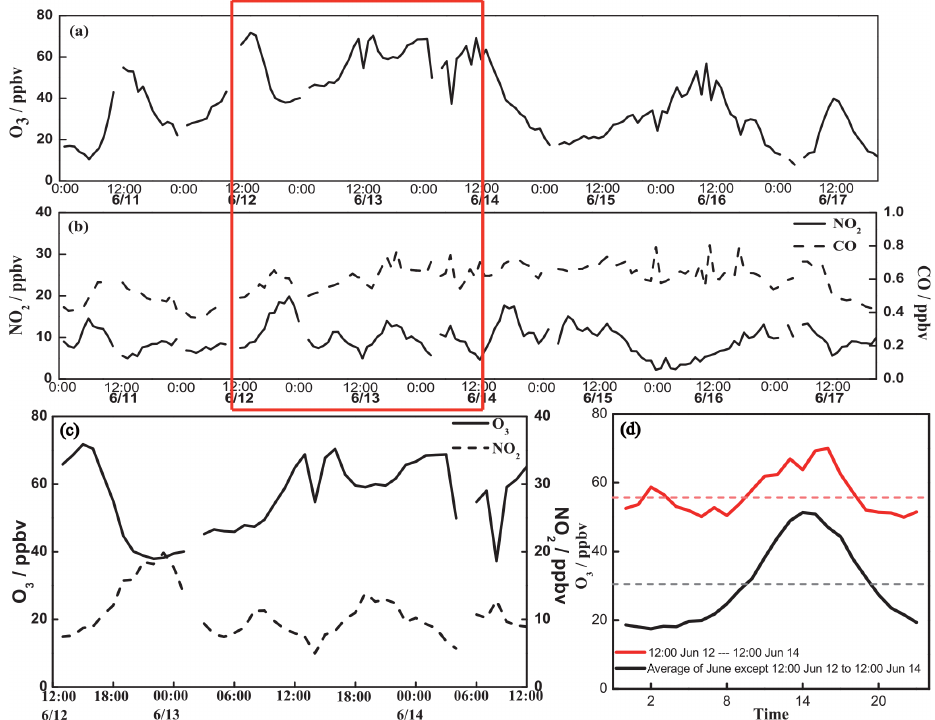
Figure 3. Hourly variations in the eight-site averaged surface concentrations of (a) O 3 , (b) NO 2 during 11–17 June with the red rectangular column marking the period of surface O 3 event and (c) O 3 and NO 2 for the surface O 3 event over XQR, as well as (d) diurnal changes of surface O 3 from 12:00 12 June to 12:00 14 June (red curve) and in June excluding 12–14 June 2014 (black curve) with two dotted lines indicating the daily averaged O 3 concentrations for two diurnal